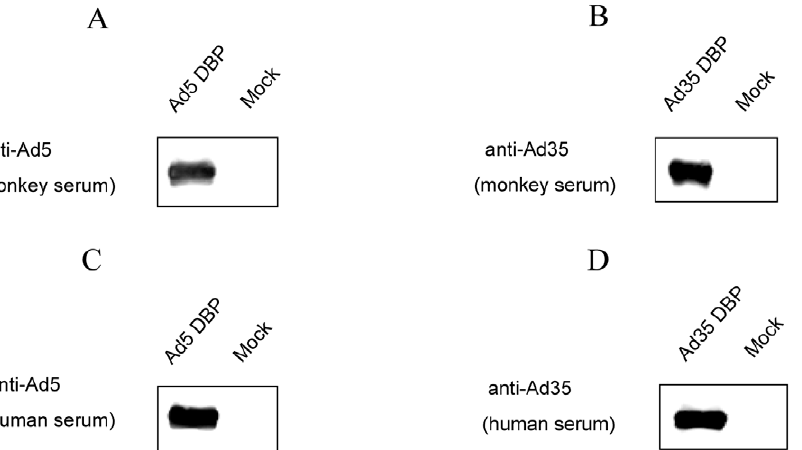
Figure 2. Antigenicity of Ad5 and Ad35 DBP. The Ad5 and Ad35 DBP were expressed in insect cells. Western blot analysis were performed to determine the antigenicity of Ad5 and Ad35 DBP using corresponding anti-DBP serum (1:1,000 dilutions) derived from rhesus monkeys (A and B) and anti-Ad5 and Ad35 serum (1:400 dilutions) derived from healthy adult volunteers (C and D). doi:10.1371/journal.pone.0056708.g002 PLOS ONE |